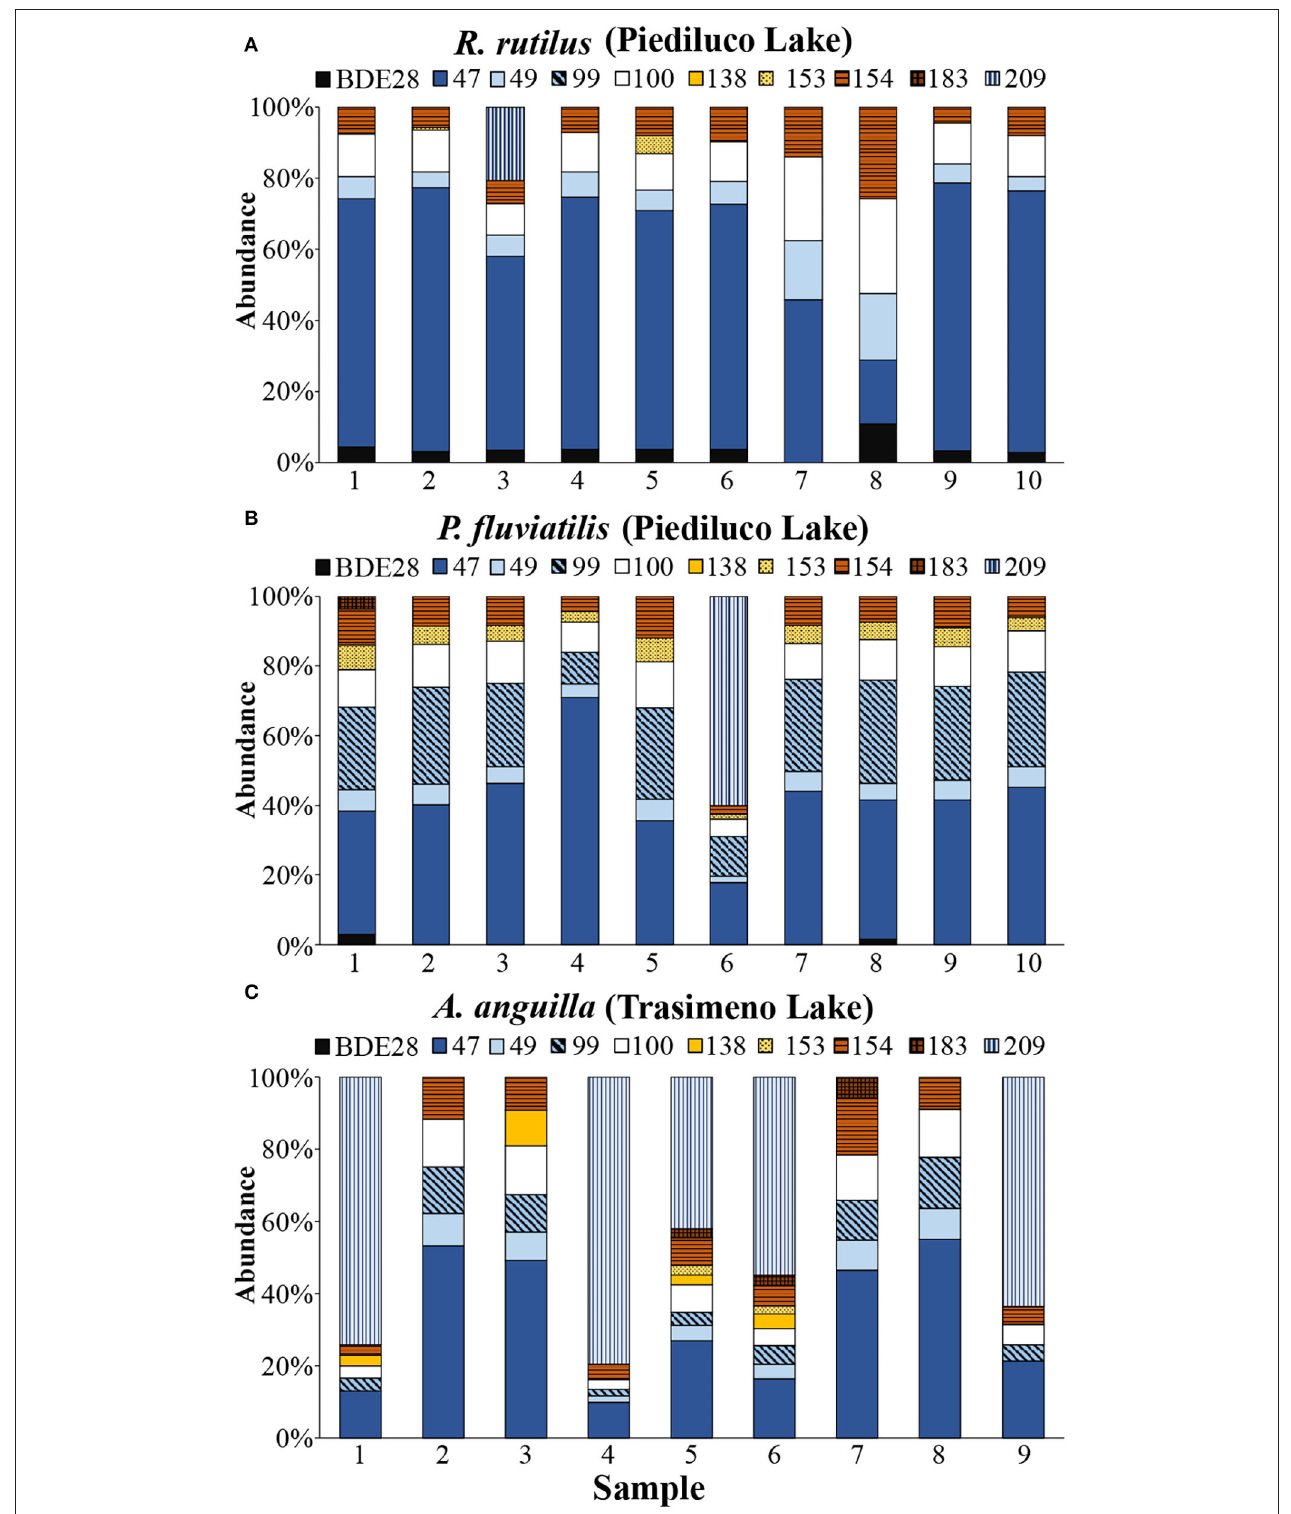
FIGURE 5 | PBDEs contamination patterns in muscle of (A) Rutilus rutilus and (B) Perca fluviatilis sampled in Piediluco Lake and in (C) Anguilla anguilla sampled in Trasimeno Lake.